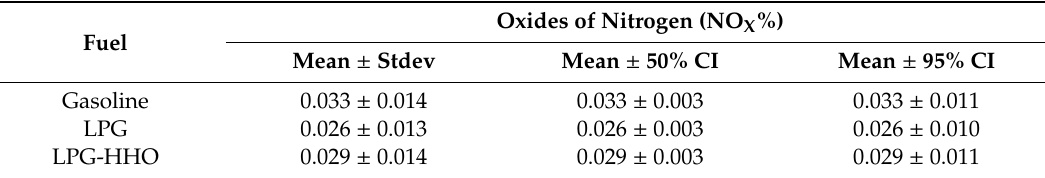
Table 6. 50% and 95% confidence intervals for mean NO X